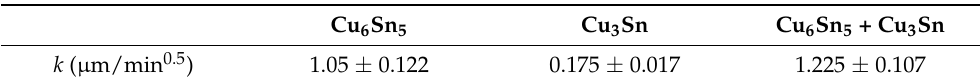
Table 1. Growth rate constants ( k ) of Cu 6 Sn 5 , Cu 3 Sn, and Cu 6 Sn 5 + Cu 3 Sn for the liquid/solid reactions at 265 ◦ C.